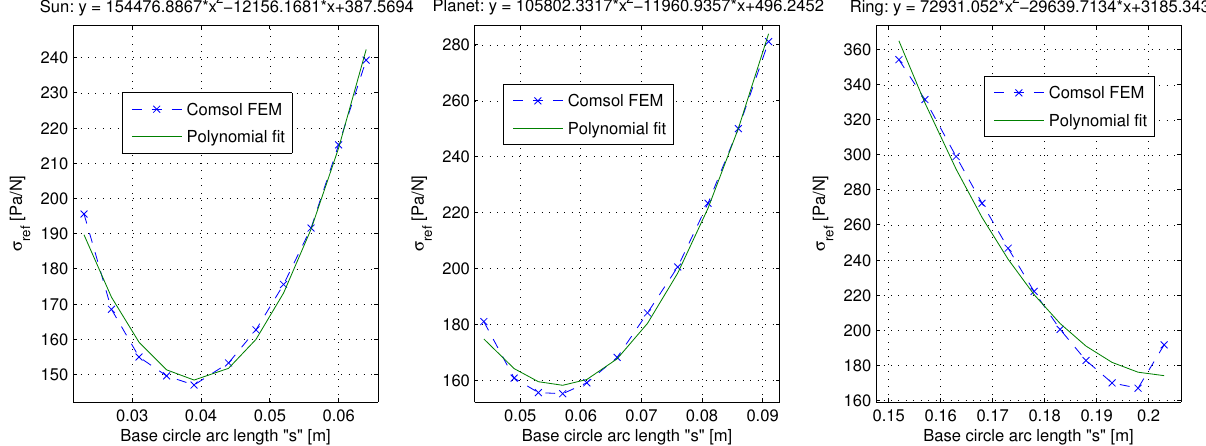
Figure 9: Maximum von Mises stress at gear tooth for a unit force (1 N) applied at a given base circle arc length distance (cid:16)s(cid:17). A second order polynomial (cid:28)t approximates the FEM-results well, for the base circle arc length intervals of